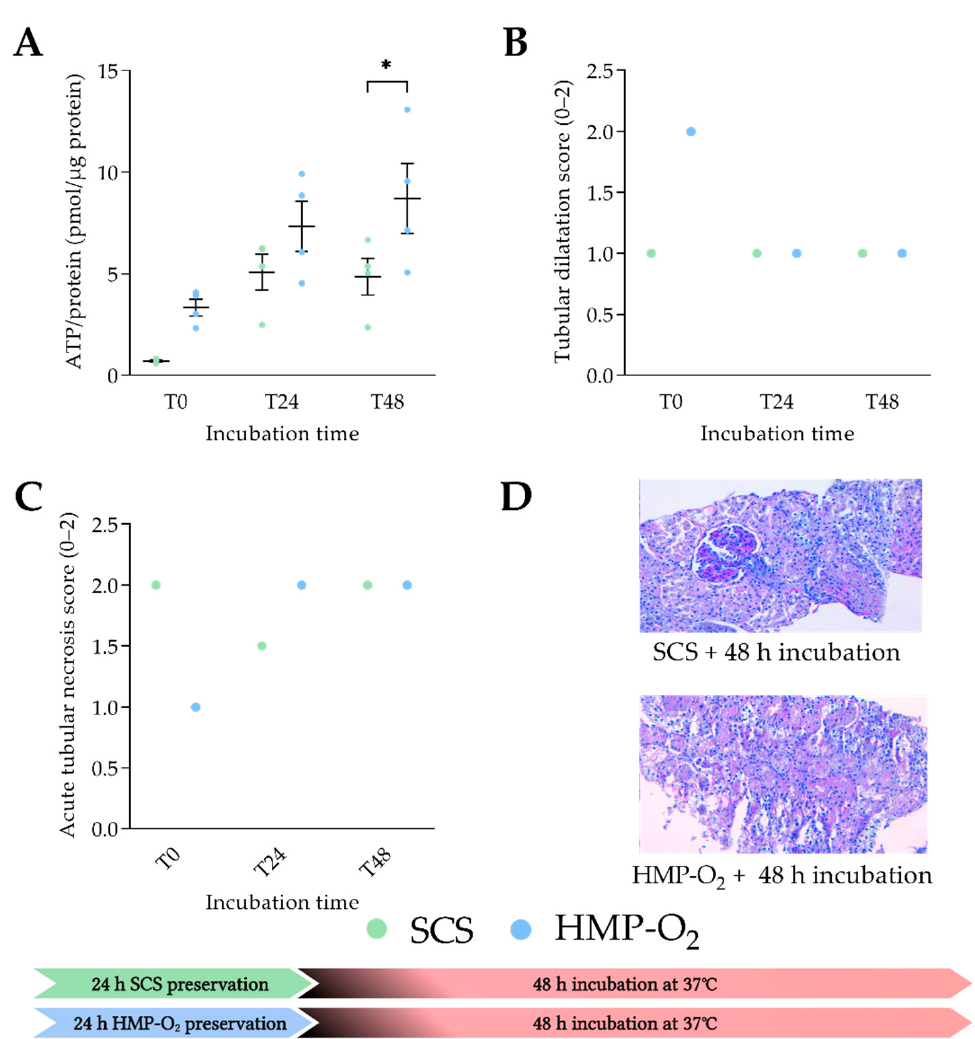
Figure 2. Tissue viability during PCKS incubation after cold preservation. ( A ) ATP levels of porcine kidneys that were preserved with oxygenated HMP (HMP-O 2 ) ( • ) ( n = 4) or static cold storage (SCS) ( • ) ( n = 4) for 24 h. ( B ) Histological tubular dilatation score of porcine kidneys. ( C ) Histological acute tubular necrosis score of porcine kidneys preserved with HMP-O 2 or SCS. ( D ) Histological images after 48 h of incubation of PCKS. T0 represents ATP/protein levels directly after slicing and T24 and